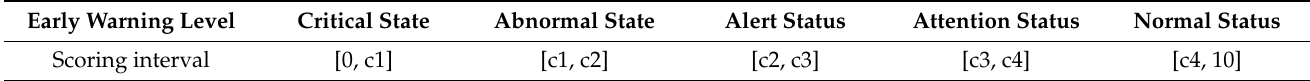
Table 9. The distribution of score